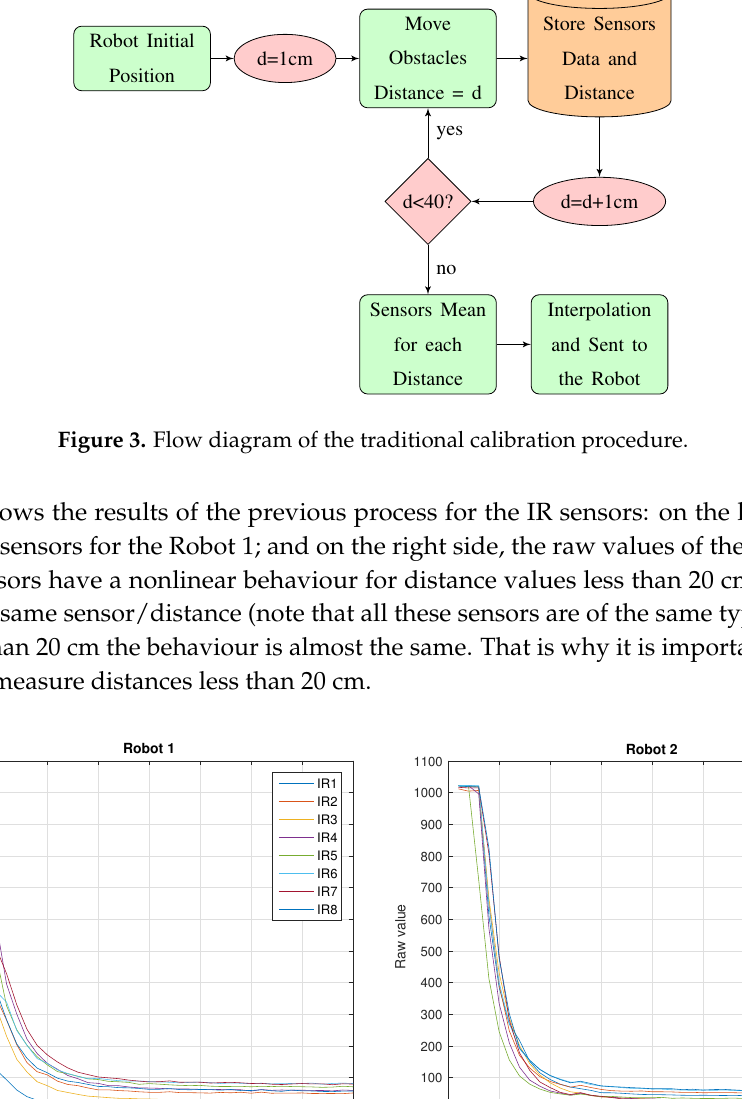
Figure 3. Flow diagram of the traditional calibration procedure